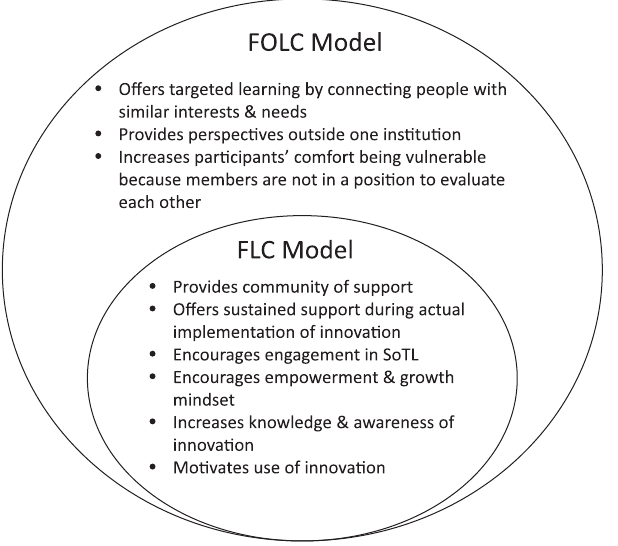
FIG. 1. The benefits of two change models. The FOLC model incorporates the advantages of FLCs while adding further